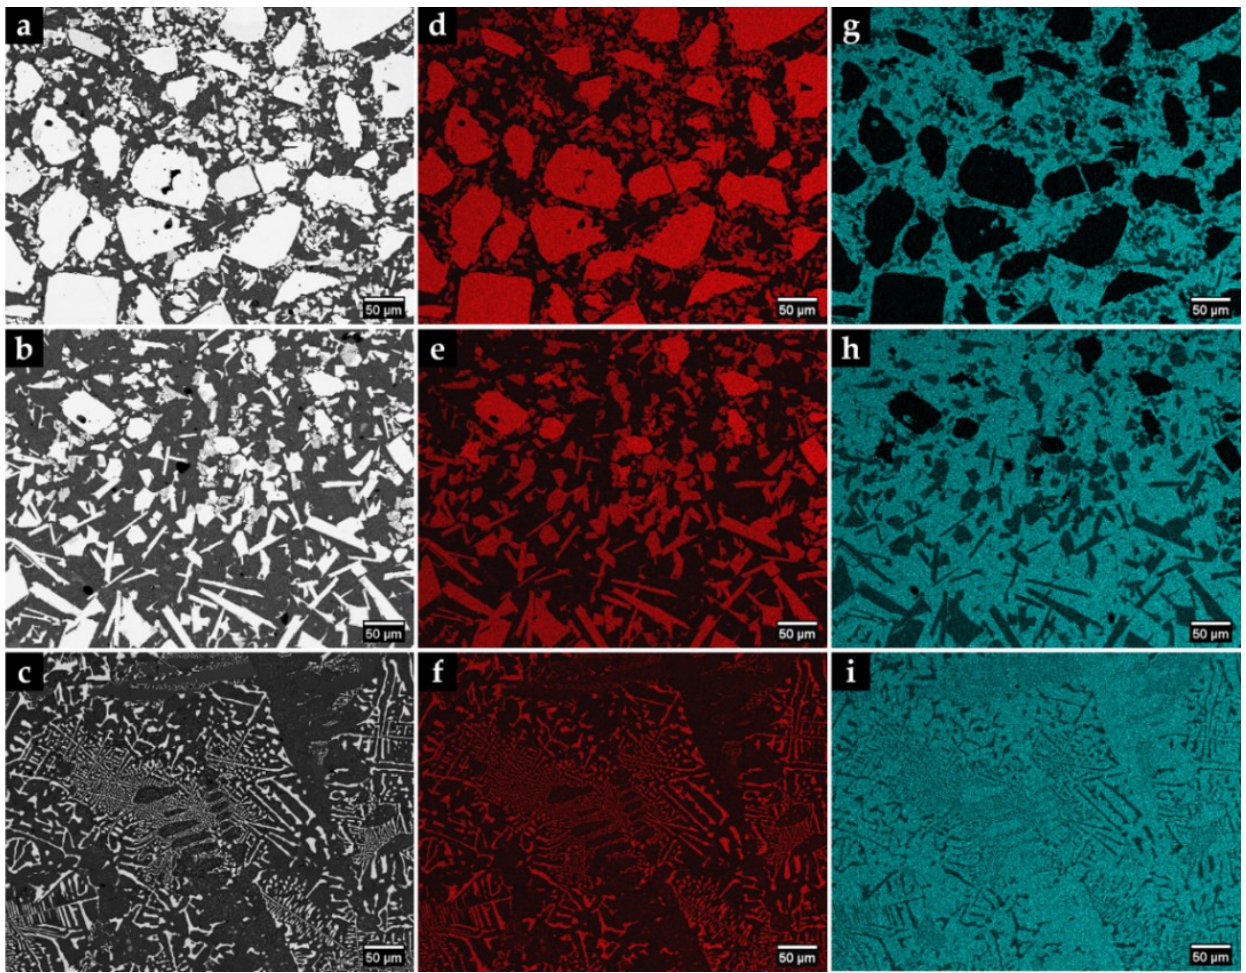
Figure 2. SEM – BSE images of the microstructure of the CZ1 ( a ) and CZ2 ( b ) and CZ3 ( c ). EDS elemental mapping ( d – i ) of W (red) and Fe (blue).